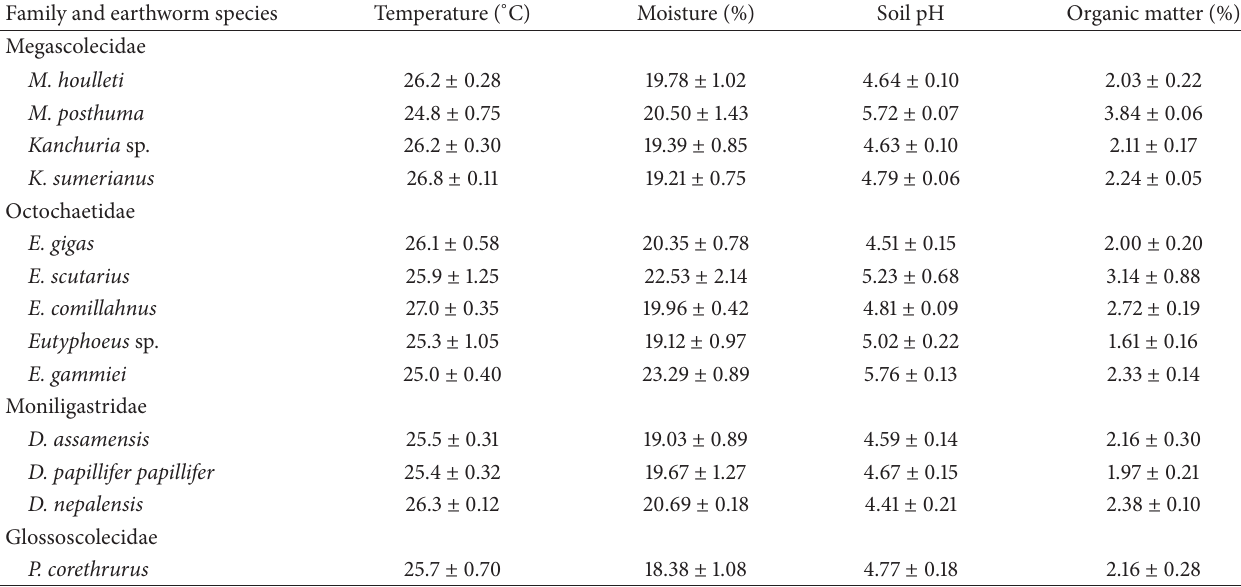
Table 5: Occurrence of different earthworm species of pineapple plantation in different ecological conditions in Tripura.